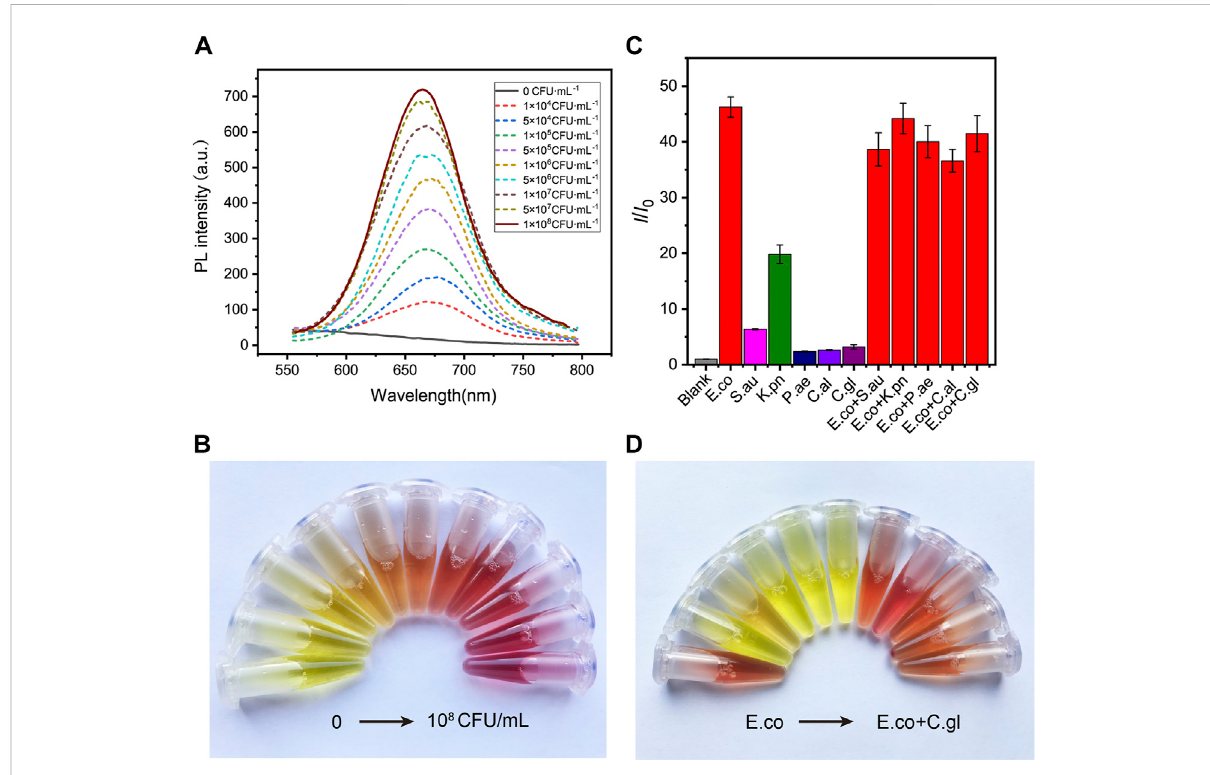
FIGURE 4 Thesensitivityandspeci fi cityofDCM- β galbasedassayto E.coli. (A) DCM- β galbasedassayforthedetectionof E.coli intheconcentrationrange of 0 – 1.0 × 10 8 CFU ml − 1 and (B) its corresponding color changes. Error bars indicate ± SD of triplicate measurements. (C) Fluorescence ratio (I/I 0 ) of speci fi city of the DCM- β gal probe against E.coli , S. aureus , K. pneumonia , P. aeruginosa , C.albicans , C.glabrata , E.coli + S. aureus , E.coli +